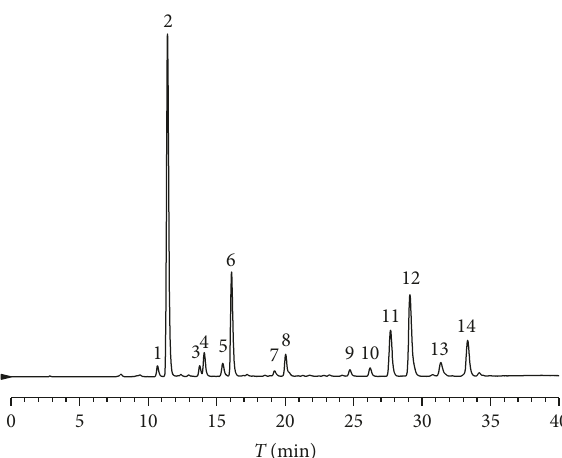
Figure 14: HPLC chromatogram profile of ME extracted by using the UE method.